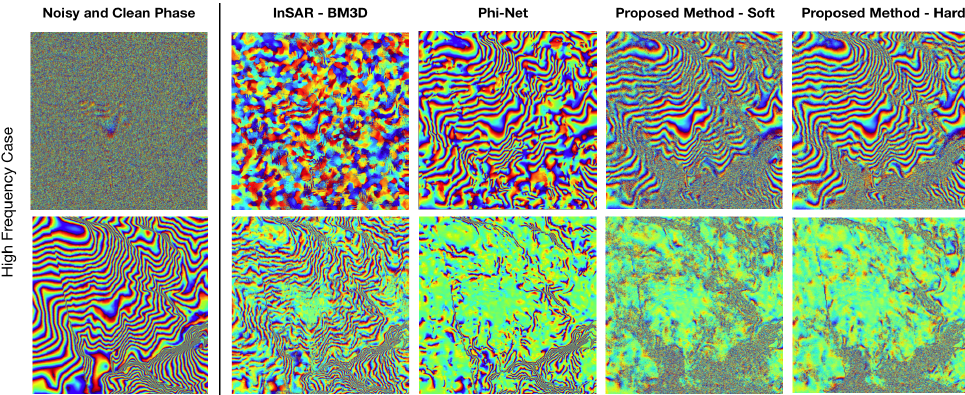
Figure 11. Filtered interferometric phase ( top ) and corresponding residues ( bottom ) of the three compared methods tested on high-frequency synthetic data.